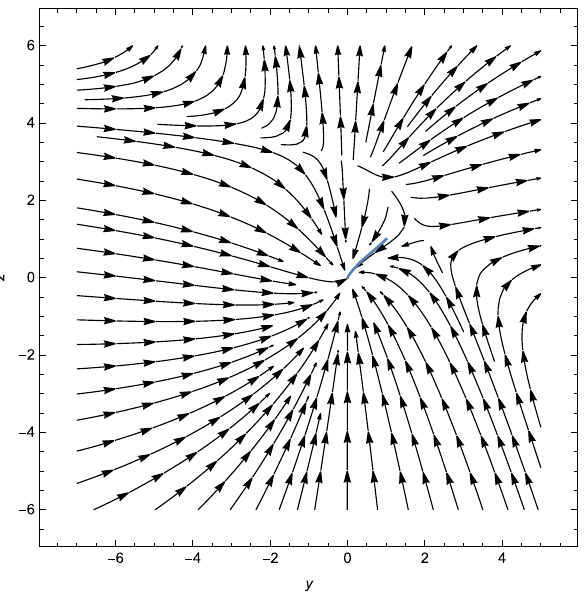
Fig. 9 The phase plot of stable attractor ( 0 , 0 ) for analysing stability at infinity for case I when γ = 0, α 2 < 3 taking C o = 8 π G = 1 for γ = 0. Figures 11 and 12 show the phase plot for unstable saddle point and repeller for respectively for γ = 4 the degree of f ( x , y ) and g ( x , y ) is odd, the behavior at the antipodal point ( − 1 , 0 , 0 ) is exactly the same as the behavior at ( 1 , 0 , 0 )